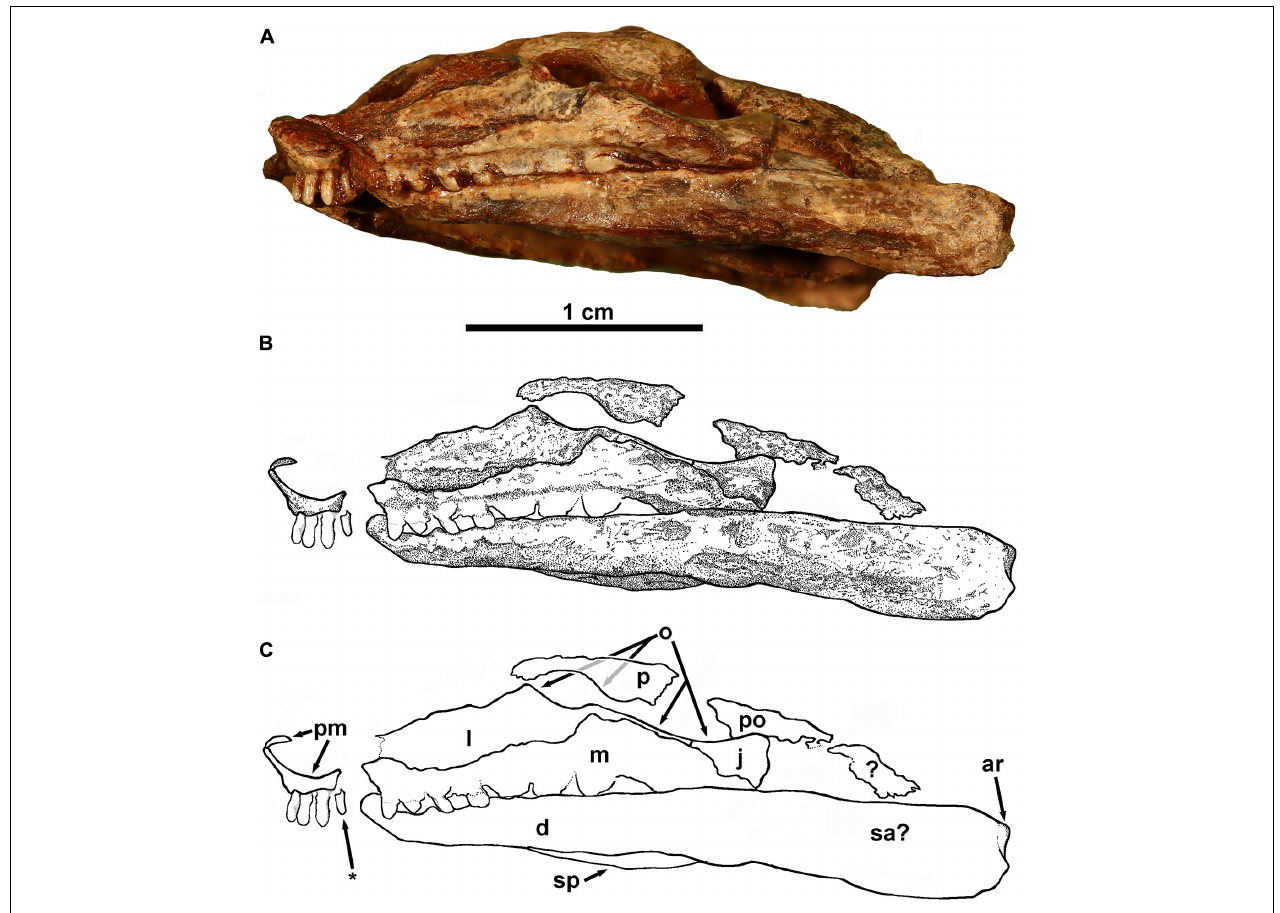
FIGURE 4 | Eudibamus cursoris , holotype (MNG 8852). Partial left lateral view of skull. (A) Photograph, (B) illustration, and (C) labeled outlines drawings of elements. *Indicates visible tooth of right